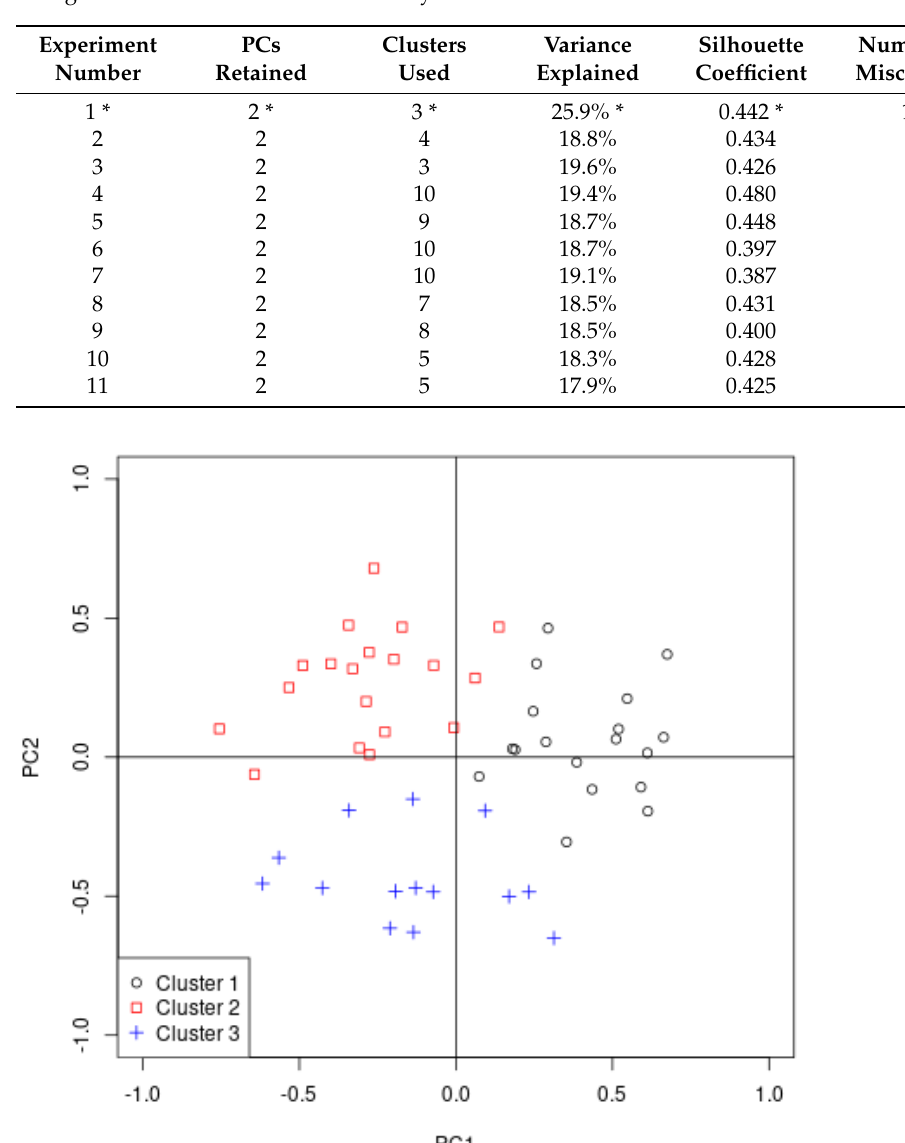
Table 3. Statistical results from experiments used to identify the optimal PCA and CA configuration. Each of the listed values from each experiment represent the most optimal PC-cluster configuration associated with the NARR field(s) retained for that specific experiment. Starred fields represent the configuration used for the statistical analysis.